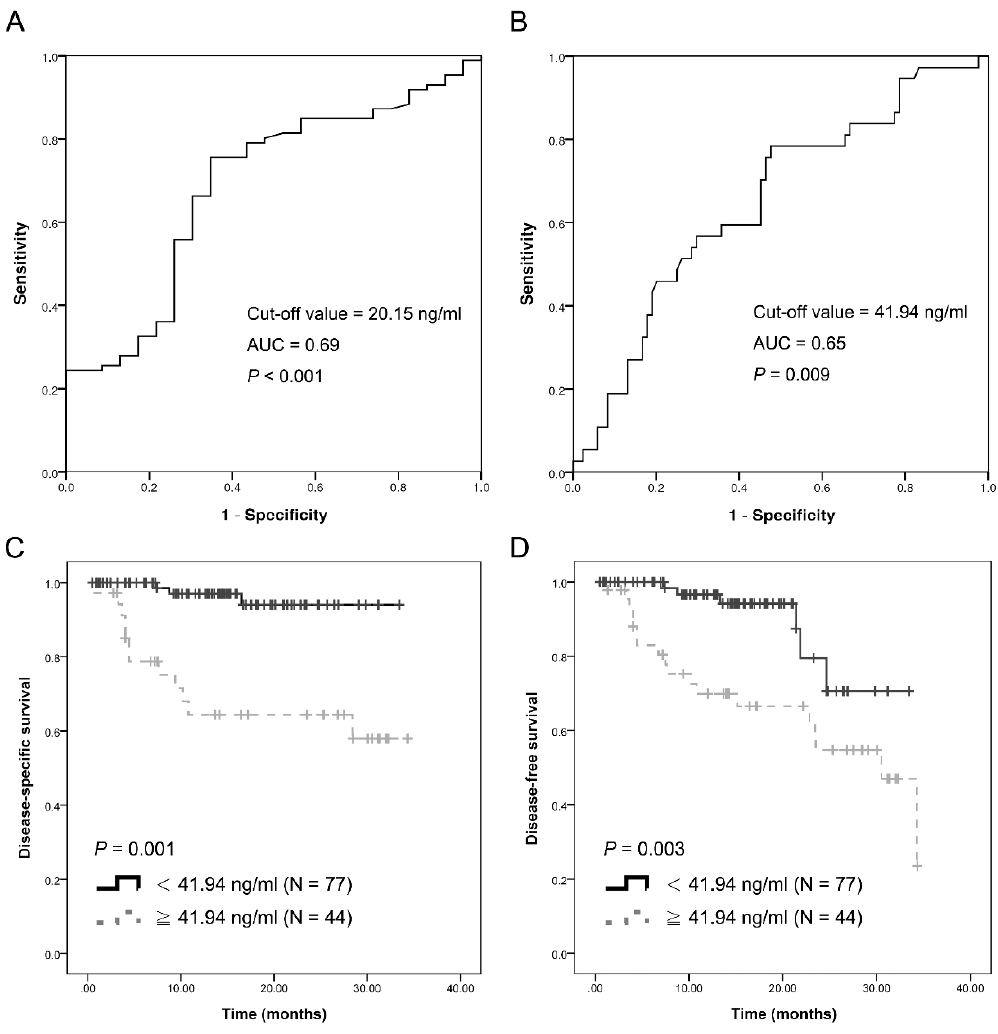
Figure 3. Receiver operating characteristic (ROC) and leave-one-out cross-validation (LOOCV) analysis across control and pre-operative samples ( A ) lymph node metastasis status ( B ) and disease specific survival samples ( C ). Plasma cfDNA Kaplan–Meier analysis of disease specific survival for OSCC patients. Higher plasma cfDNA concentrations demonstrated a poor prognosis in OSCC. ( D ). Plasma cfDNA Kaplan–Meier analysis of disease free survival for OSCC patients. Higher plasma cfDNA concentrations demonstrated more relapsed in OSCC. Table 2. Association between cfDNA content and OSCC